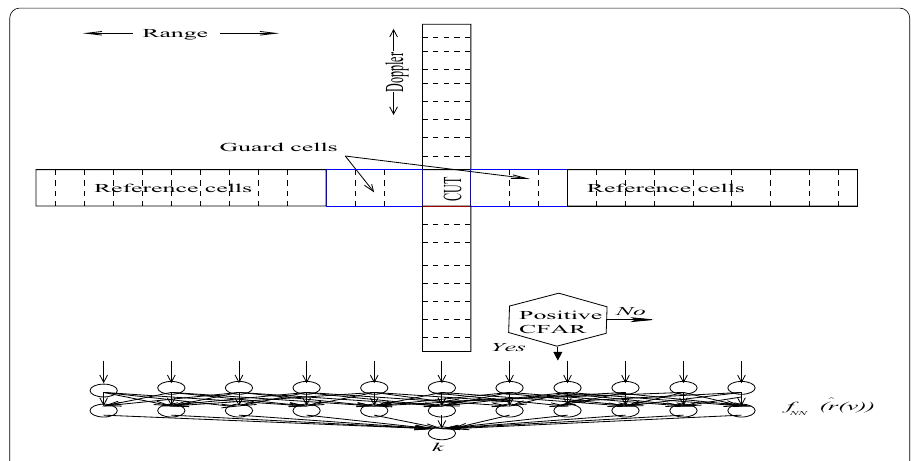
Fig. 1 Schematic description of the detection process and data linked with a neural